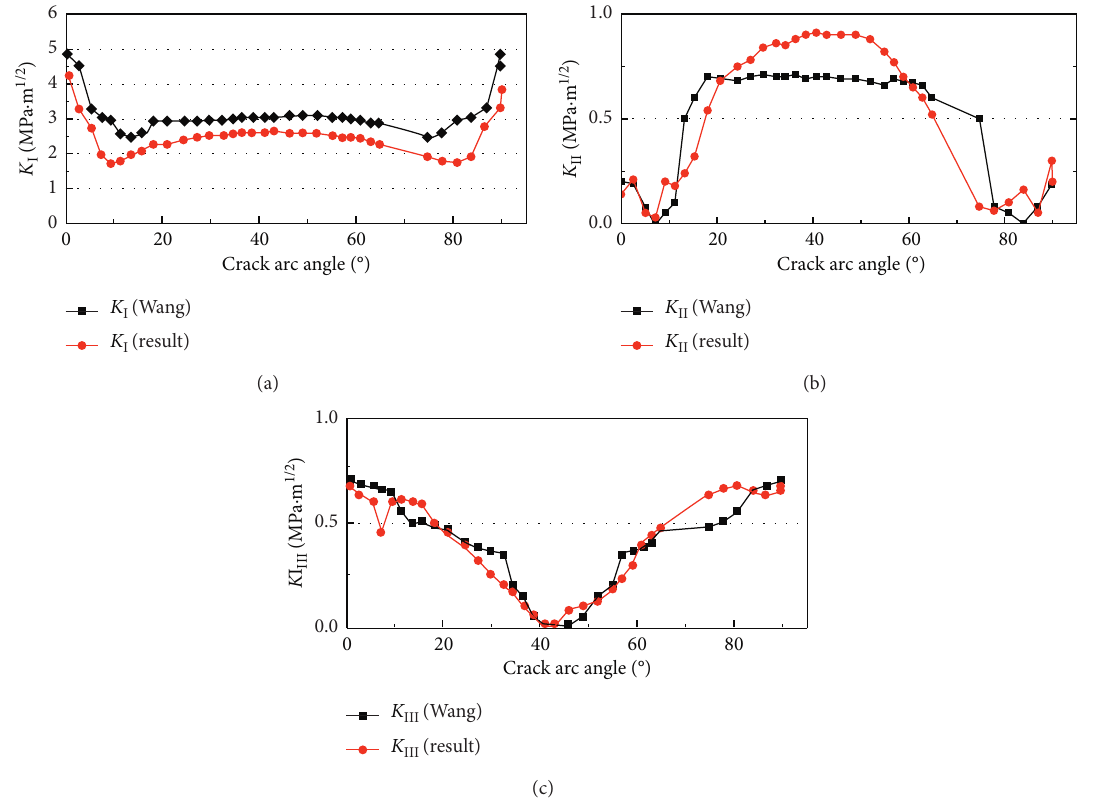
Figure 10: Comparison of calculation results of SIFs: (a) K